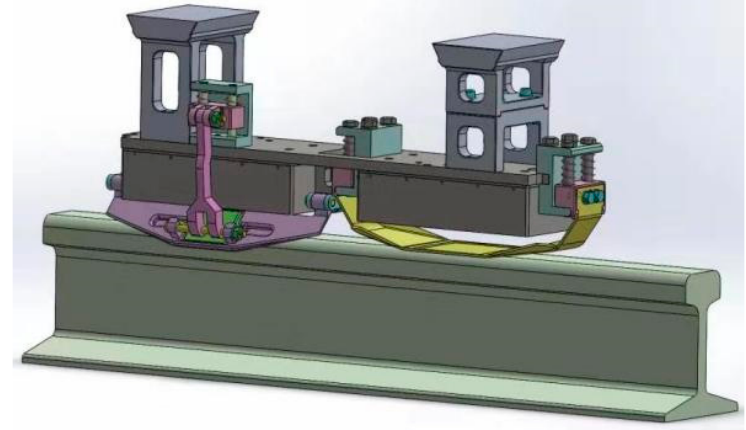
Figure 9. The installation of the sliding shoe.